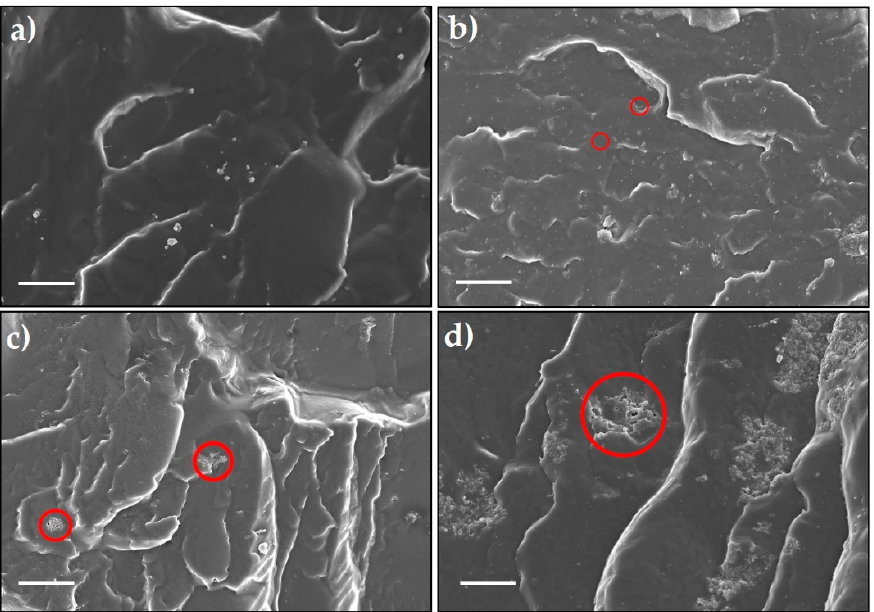
Figure 5. SEM images of the fracture surface of ( a ) Pure thermoplastic polyurethane (TPU), ( b ) CN-TPU, ( c ) PCN-TPU, and ( d ) Co@PCN-TPU (scale bar: 15 μ m).